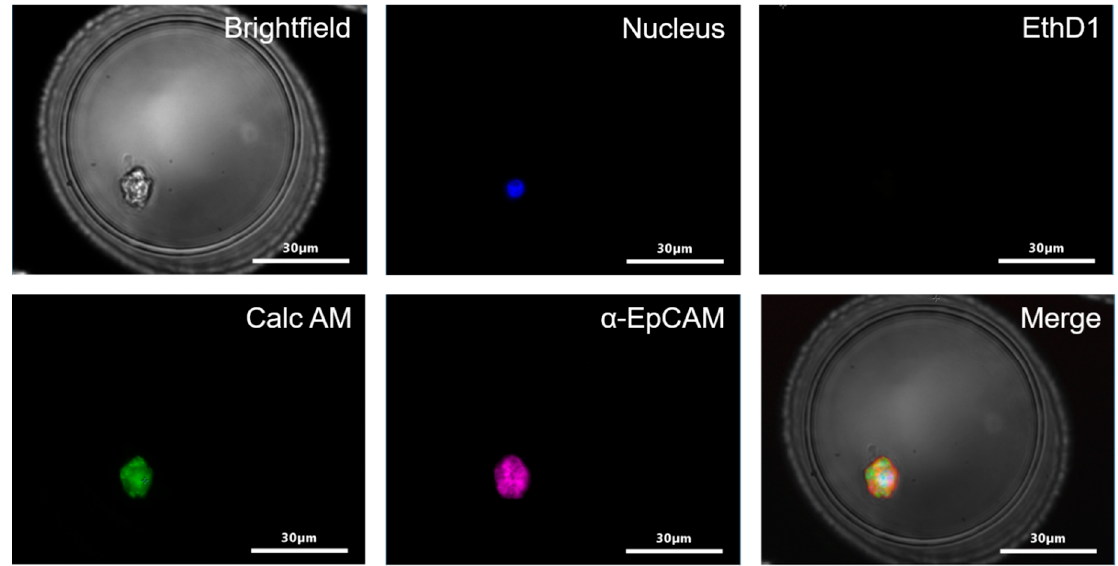
Figure 5. Identification of MCF-7 cell in a microwell. Bright field, Hoechst 33342 (nucleus) (blue), EthD1 to identify death cells (red), Calcein AM (Calc AM) to identify viable cells (green), EpCAM-Alexa647 to identify cells of epithelial origin (purple). Not shown is the CD45-PerCP image to identify leukocytes. Table 1. Recovery and viability after processing 7.5 mL EDTA blood spiked with ~100 MCF-7 and ~100 MDA-MB-231 cells. After 2 days of cell culture the percentage of cells that showed cell growth was determined. In two of the experiments an infection was observed